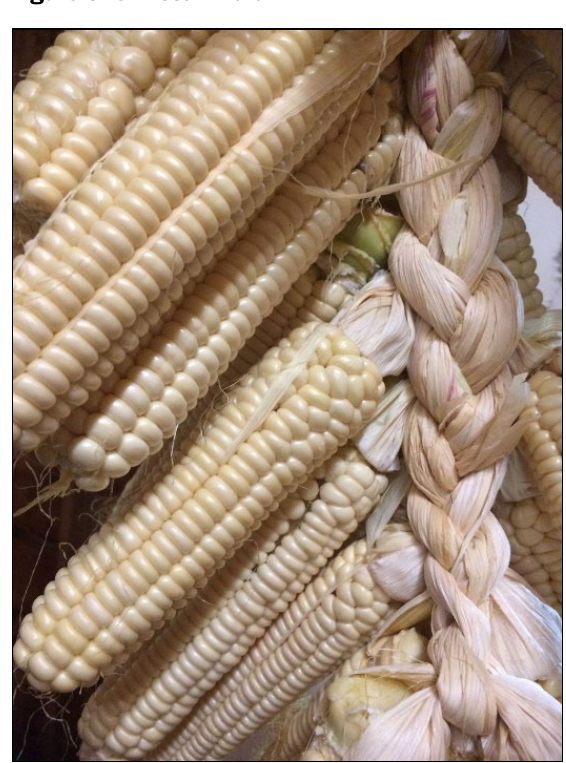
Figure 3. O·n ʌ́ ste ˀ Braid